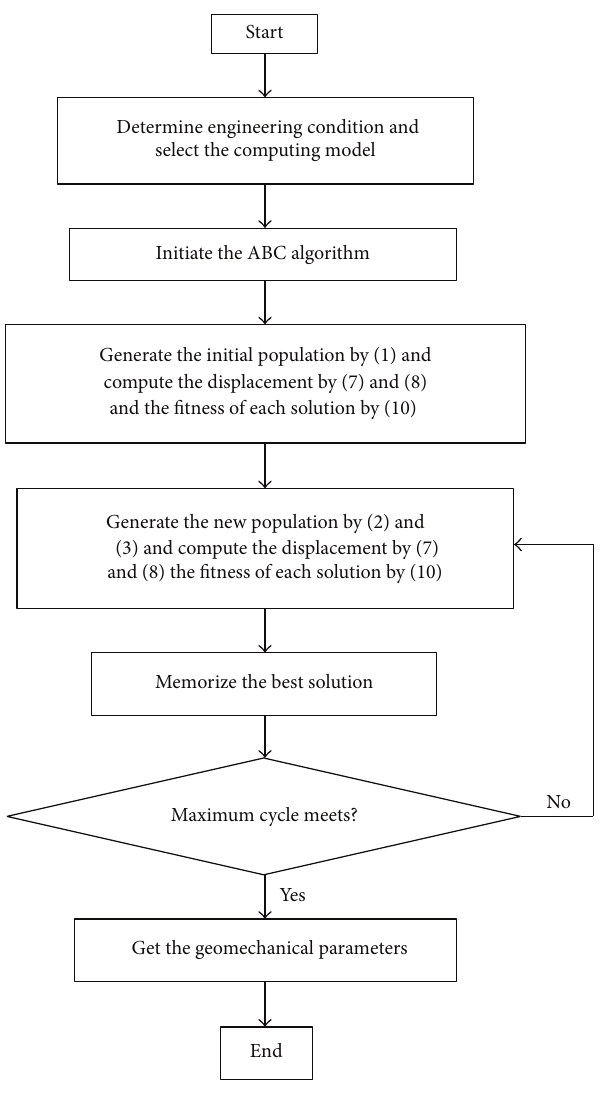
Figure 2: Flowchart of ABC-based back analysis.